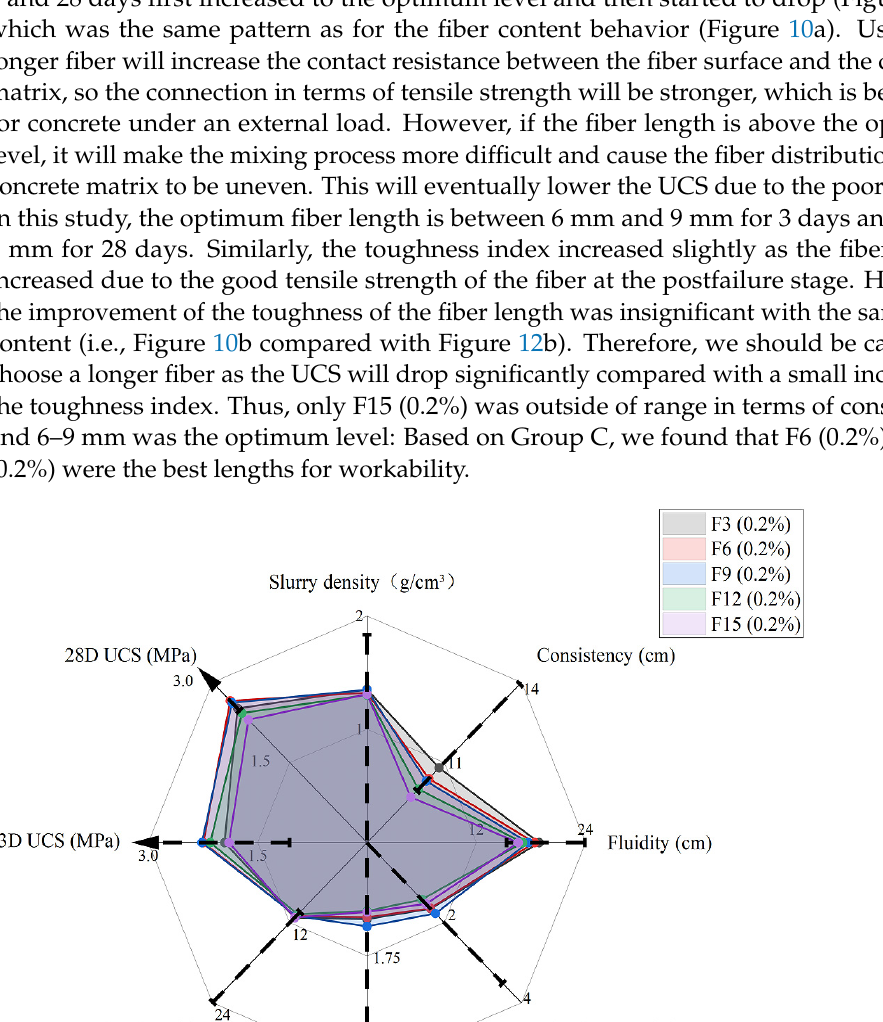
Figure 12. UCS for different fiber lengths ( a ) and toughness indices for different fiber lengths ( b ) at rubber content of 60% and fiber content 0.2%. 6. Conclusions A series of experimental tests were conducted to evaluate the physical properties of an innovative grouting material by introducing porous sand and fiber to rubber concrete. The toughness index of the material was improved, which was beneficial for the postfail- ure stage. It was found that increasing the fiber content enhanced the mechanical proper- ties (i.e., UCS and toughness index). However, the increasing fiber content compromised the workability of the grouting material (e.g., fluidity). Thus, the best value for fiber con- tent had to be determined experimentally and was found to be 0.2% in this study. Simi- larly, the fiber length also had an optimum value (about 6 to 9 mm in this study). Above the optimum, the grouting material is less useful in terms of fluidity and makes mixing impossible. Additionally, for fiber lengths up to 15 mm, the toughness index only in- creased to about 3, while for fiber content up to 1%, the same toughness index increased